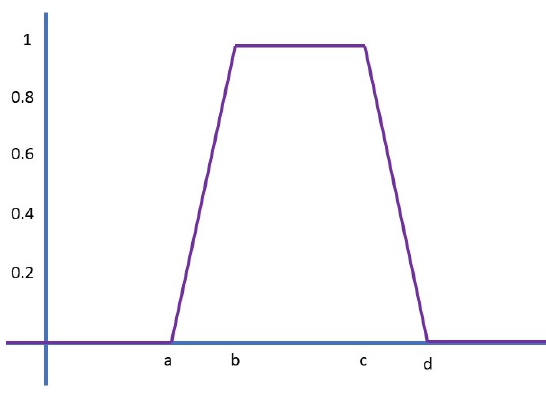
Figure 13. TrapMF Plot